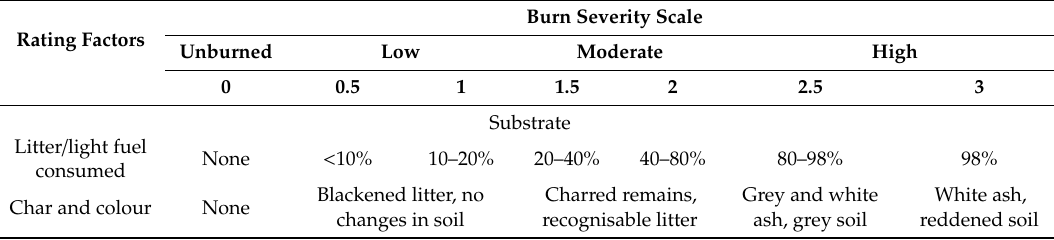
Table 1. Rating factors and scale used to quantify soil burn severity (substrate stratum of the Composite Burn Index according to Fern á ndez-Garc í a et al.